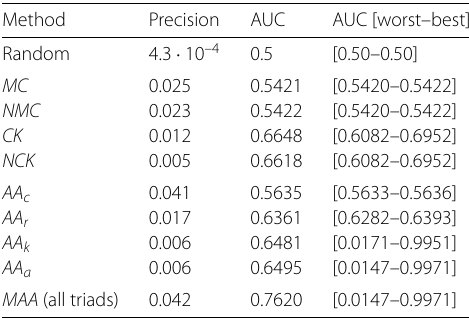
Table 2 Precision and AUC values obtained for different metrics proposed, with the theoretical bounds of the AUC. We consider dyadic metrics given by Eqs (1)–(4), triadic closure given by the AA metric, Eq. (5), applied to each layer ( AA c , AA r , and AA k ), to the aggregated network ( AA a ), and the MAA score given by Eq. (6), with coefficients η ck = 0.05 and η cr = 0.1 which maximize both AUC and Precision (see Fig. 2). Note that dyadic ( MC , NMC , CK , and NCK ) and triadic (based on AA ) methods use different amount of information, so the theoretical bounds for the AUC are different Method Precision AUC AUC